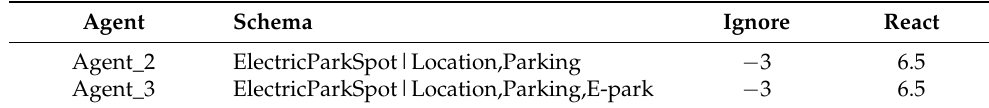
Table 2. Qmatrix of the agents after the first query (semantic version).